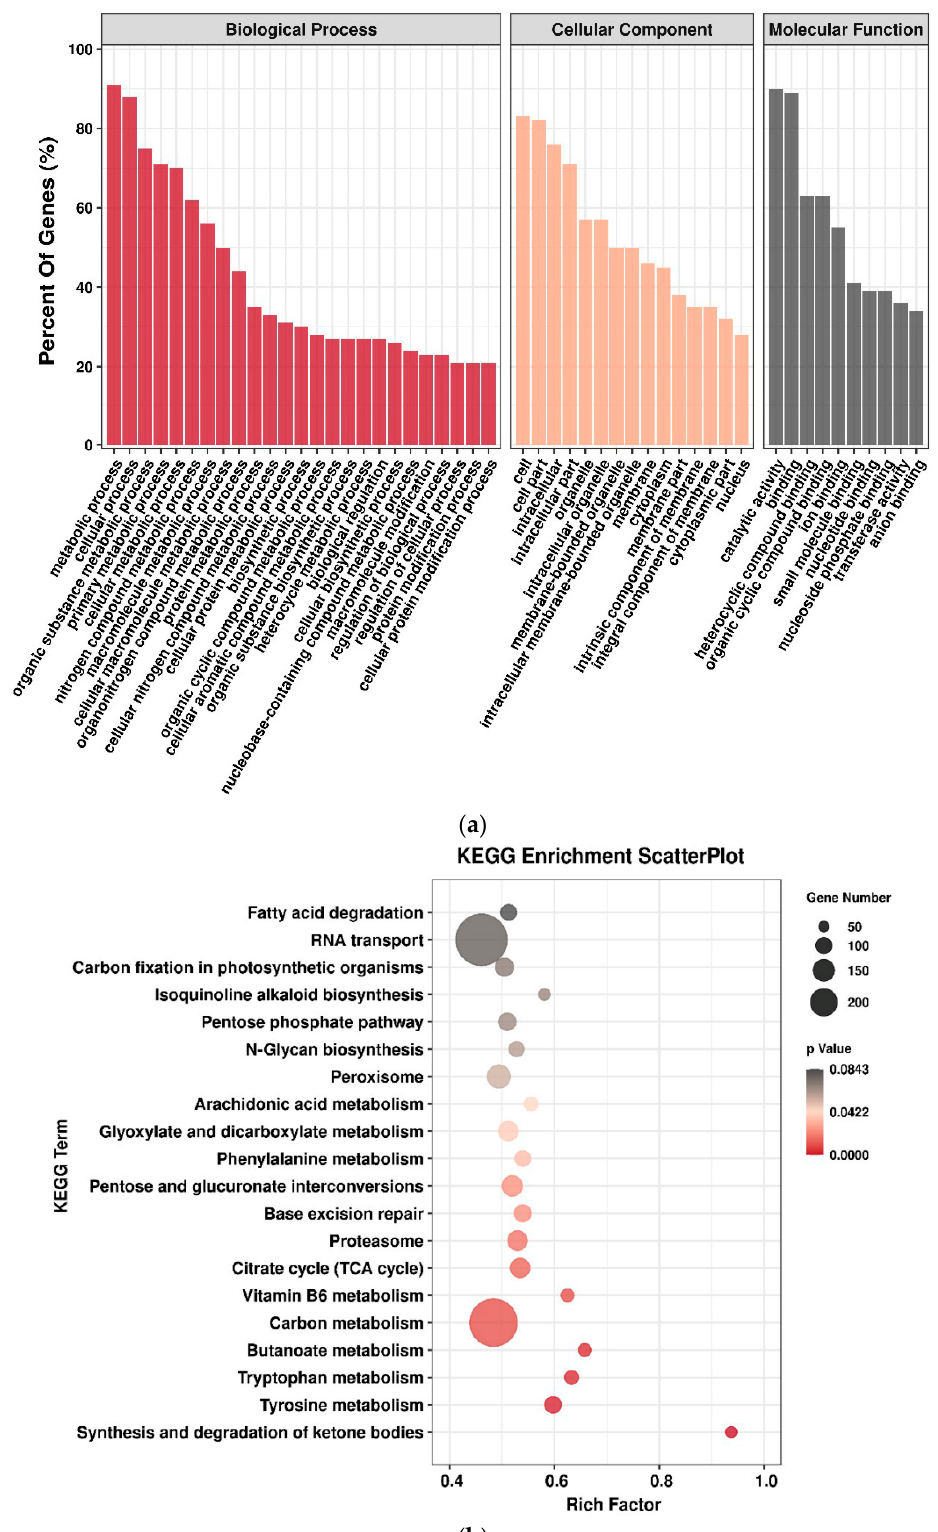
Figure 5. Gene ontology classification ( a ) and KEGG pathway enrichment ( b ) of target genes for different